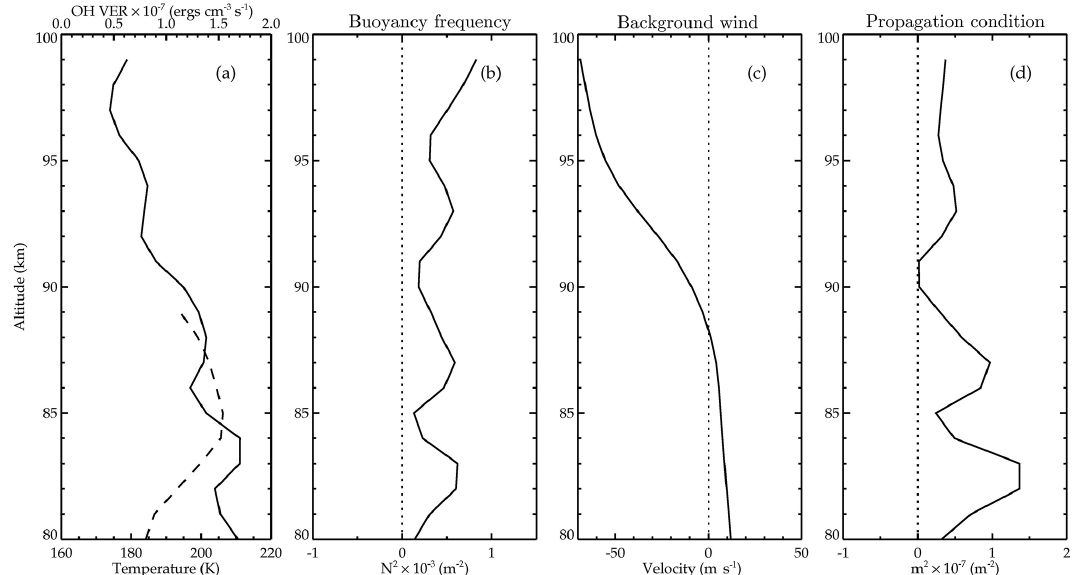
Figure 5. Atmospheric profiles for (a) temperature (solid line) and OH volume emission rate (OH-VER, dashed line), (b) buoyancy frequency ( N 2 ) , (c) wind profile in the wave propagation direction and (d) vertical propagation condition ( m 2 ). In this case the profiles were obtained for the mesospheric front observed on 5 May 2011. Table 1. Mesospheric fronts observed in 2011 at Ferraz Station and their respective parameters. Event Date and time Horizontal Period Azimuthal direction Phase (UT) wavelength (min) ( ◦ ) speed (km) (ms − 1 ) 08 May,